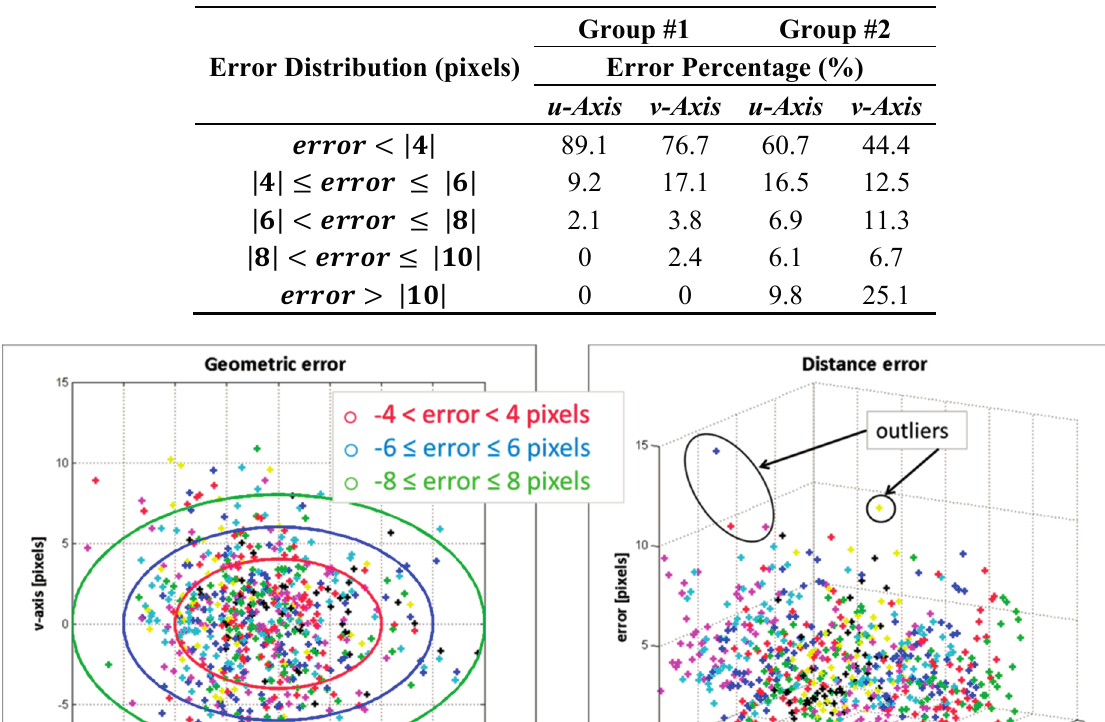
Table 4. Results of the error distribution.